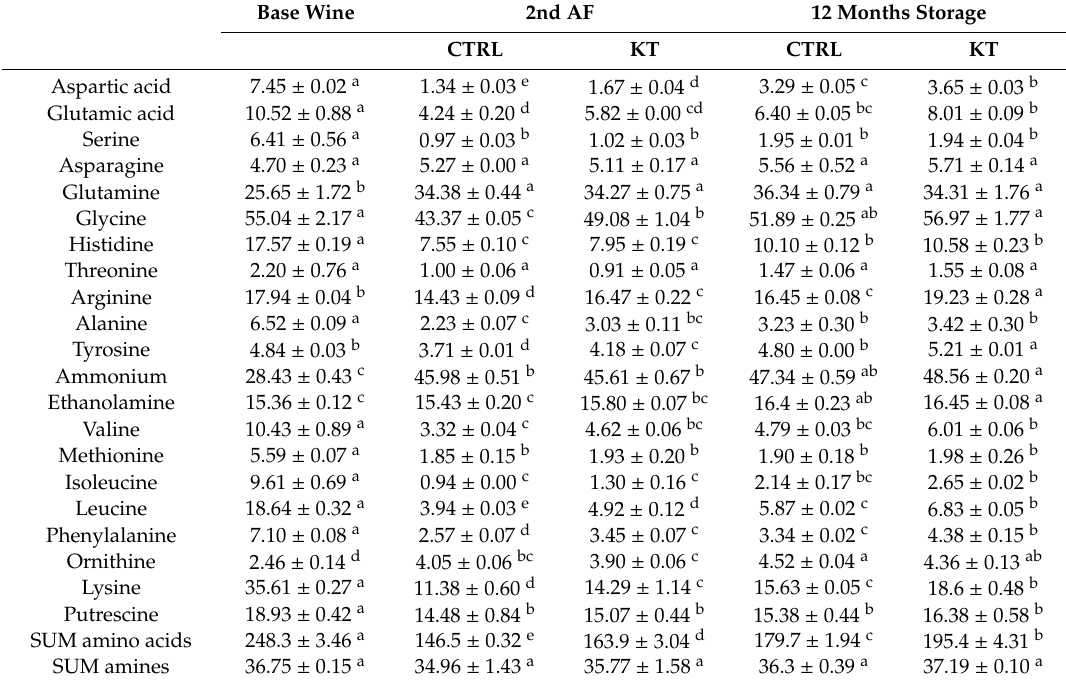
Table 4. Concentrations (mg / L ± STD) of amino acids, ammonium ion and amines after secondary alcoholic fermentation (2nd AF) and after 12 months of storage “sur lie.” In the same row, di ff erent letters indicate significant di ff erences according to Tukey’s test ( p < 0.05). n =